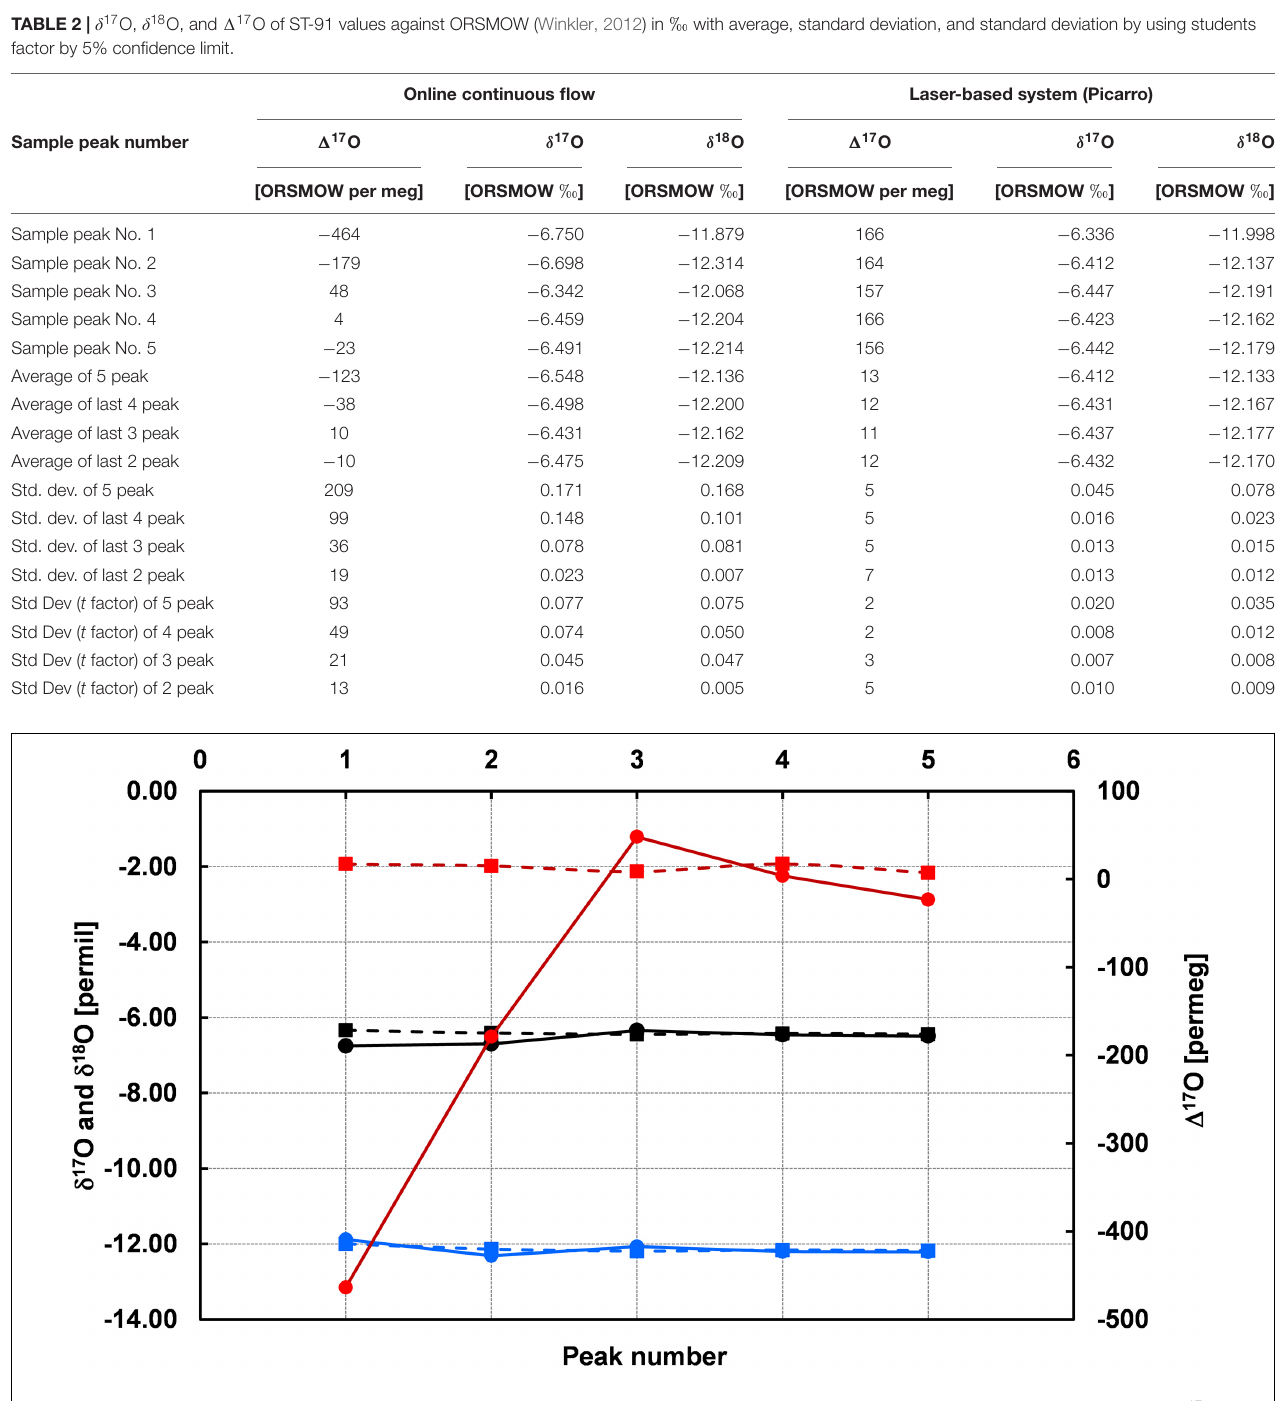
FIGURE 6 | Memory effect of the continuous flow (ConFlow) system during the sample acquisition. Memory effect can easily be seen on the first peak for δ 17 O (ConFlow, black circle), δ 18 O (ConFlow, blue circle), and (cid:49) 17 O (ConFlow, red circle) in comparison to laser-based system (LBS, square box), PICARRO. The last two peaks of each acquisition were not much influenced by the memory